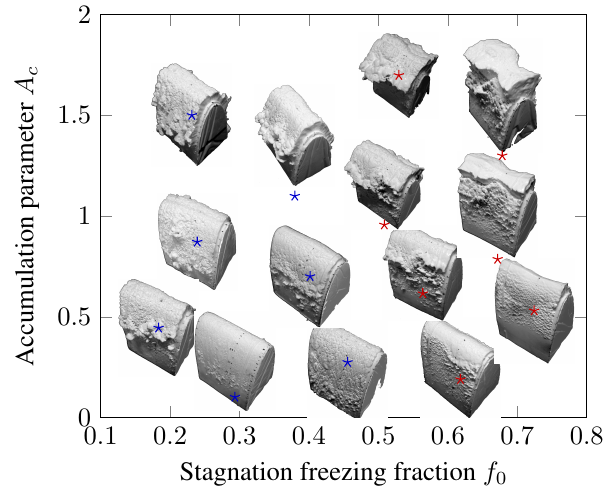
Figure 30. Experimentally observed SLD ice shapes on a NACA0012 leading edge in the parameter space of f 0 and A c , Re = 2 × 10 6 , MVD = 80µm and AoA = 0 ◦ . Results reproduced from Steiner and Bansmer